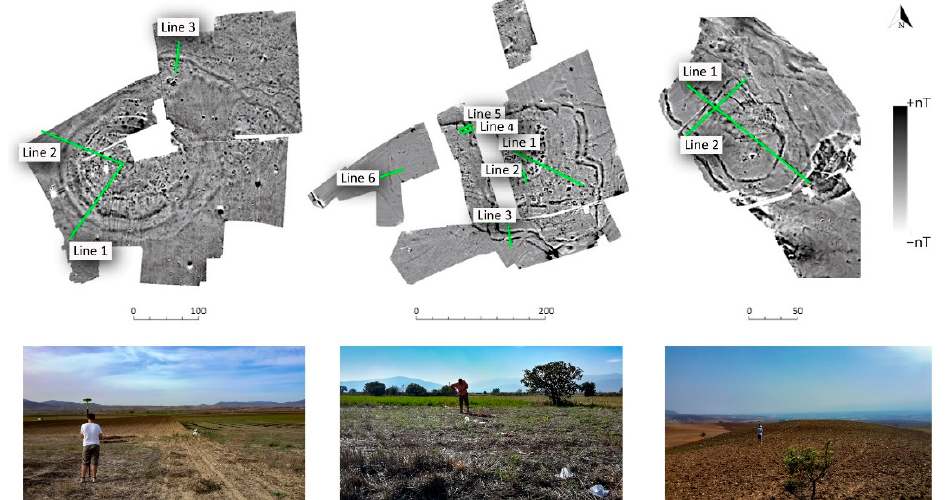
Figure 2. General location of the soil sample lines over the magnetometer results ( top ). General views of the fields during soil sampling ( bottom ). The grayscale image shows positive magnetic anomalies in black and negative anomalies in white.